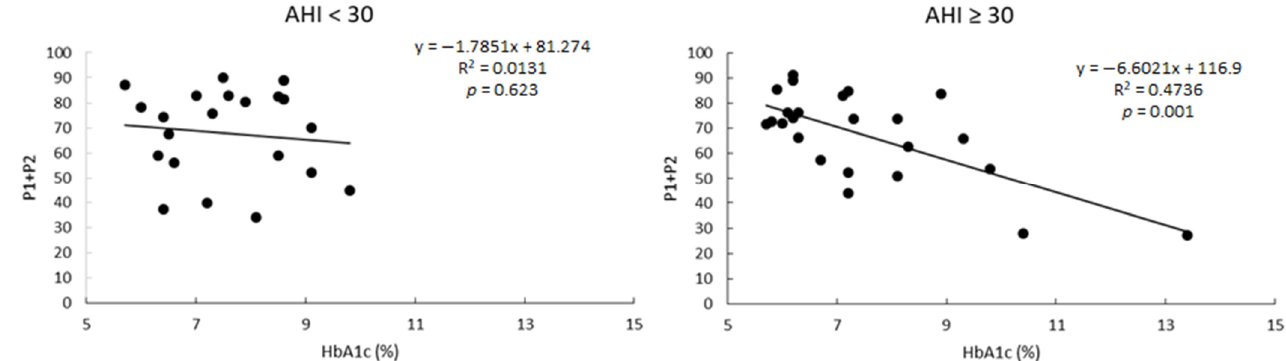
Figure 3. Linear correlations between the percentage of variance explained by a two-harmonic model (P1 + P2) and the levels of HbA1c in patients grouped as a function of the AHI levels.